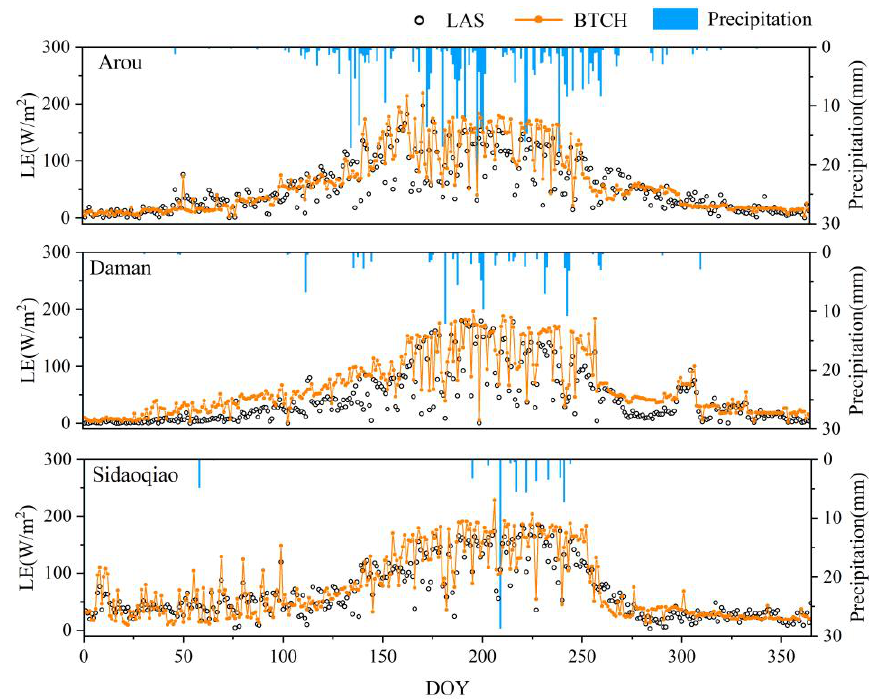
Figure 6. Temporal consistency of BTCH method with LAS observations.